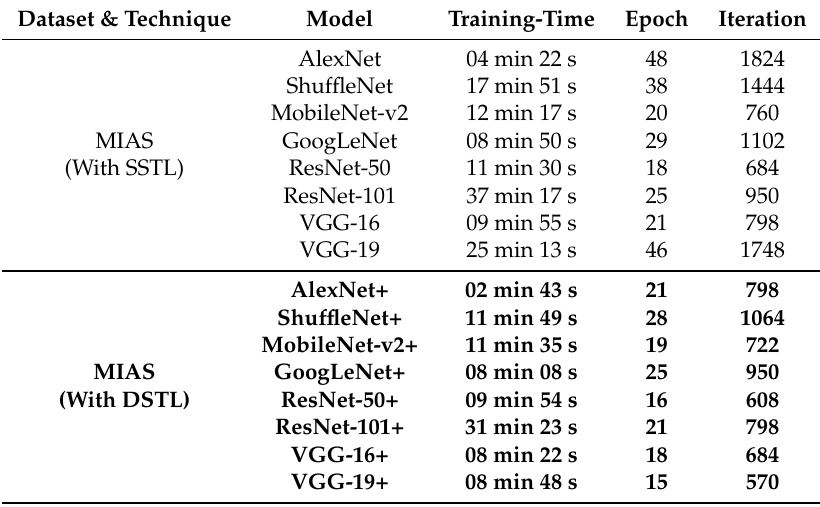
Table 9. The performance analysis of different pre-trained networks with SSTL and DSTL on MIAS and BCDR